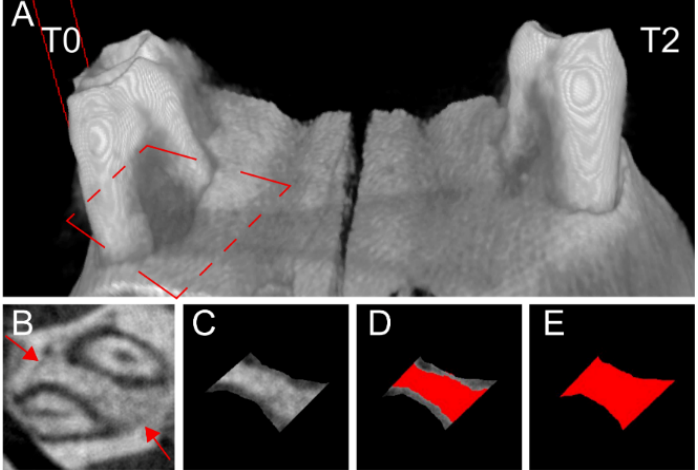
Figure 2. Micro-computed tomography (Micro-CT) images after four weeks of periodontal furcation defect healing. Reconstructed three-dimensional image of the defects with a darker area between the left molar roots without treatment (T0), compared to the defect on the right side treated with decellularized amniotic membrane and undifferentiated adipose-derived stromal cells (T2) ( A ). A dashed rectangle indicates horizontal level orientation for bone healing quantification ( A ). Micro-CT image of a left-side furcation defect treated with T2 ( B – E ). The lower bone density of the newly deposited tissue can be observed, also demarcated by the defect preparation perimeter (arrows, ( B )). Image processing for quantification using Image J software on level D, between medium and apical level, with 77% of bone tissue ( C – E ). The area between the roots was restricted with tangent lines, and the roots were contoured and excluded from the image ( C ). The area of mineralized tissue (red in ( D )) was subtracted from the total area (red in ( E )) to calculate the percentage of bone healing. Five animals with clinically deficient mucogingival closure were excluded from the ECM (T3 and 4) may explain the deficient mucogingival closure, which caused the